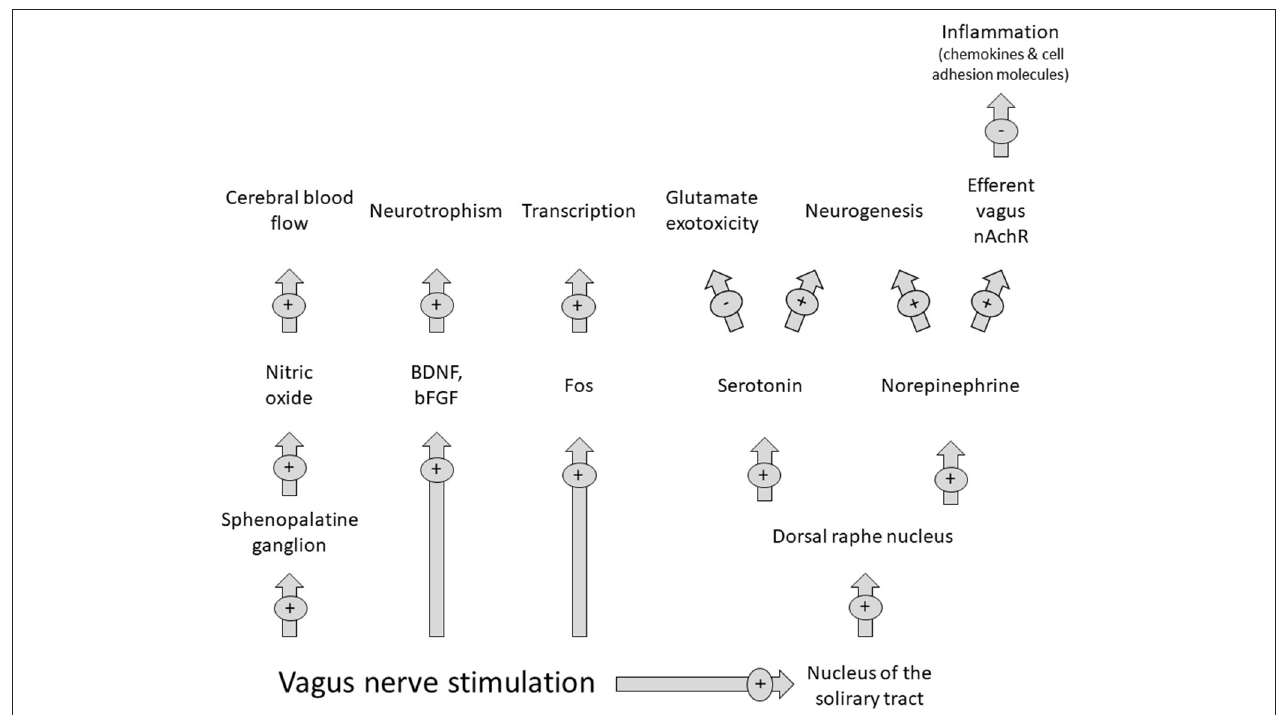
FIGURE 2 | Effects of vagus nerve stimulation on the parasympathetic nervous system. Abbreviations: BDNF: brain derived neurotrophic factor; bFGF, brain fibroblast growthfactor. Modified from Cai PY. (2014) Frontiers in Neurology doi: